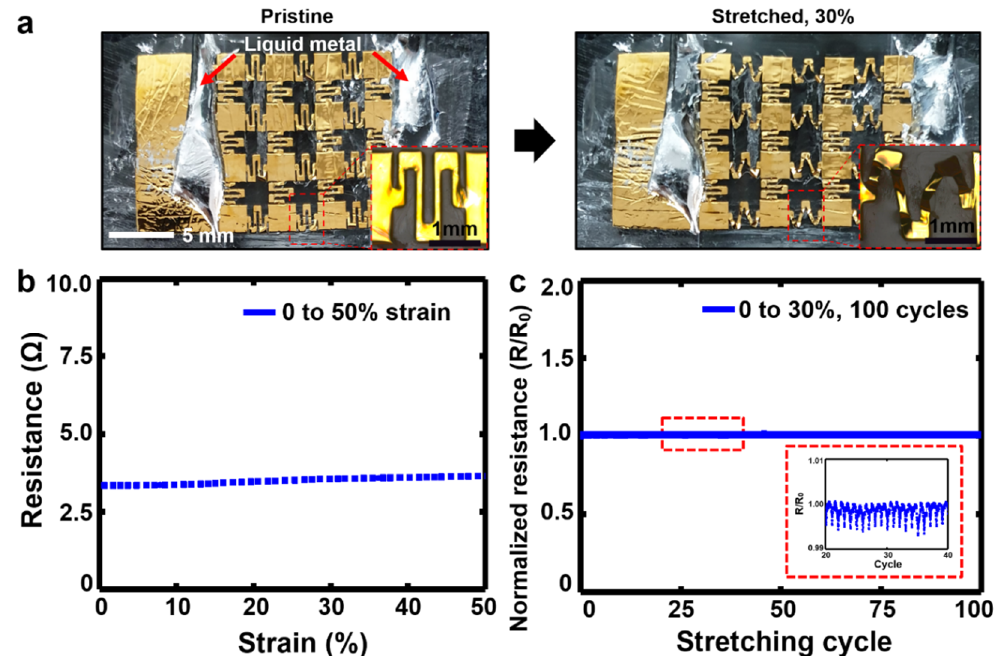
Figure 3. Mechanical stretchability and electrical stability of the stretchable EMG electrode: ( a ) Images of a pristine electrode (left) and a stretched electrode (right). Corresponding microscopic images of stretched serpentine structure (Inset); ( b ) Resistance-strain characteristics of the stretchable EMG electrode; ( c ) Normalized resistance during 100 stretching cycles. A graph of partially enlarged section (Inset).